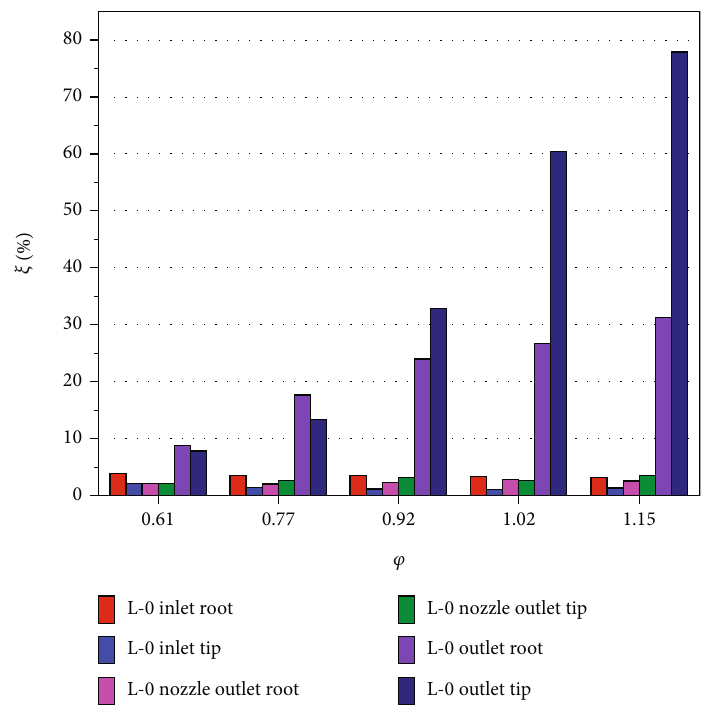
Figure 8: Comparison of static pressure